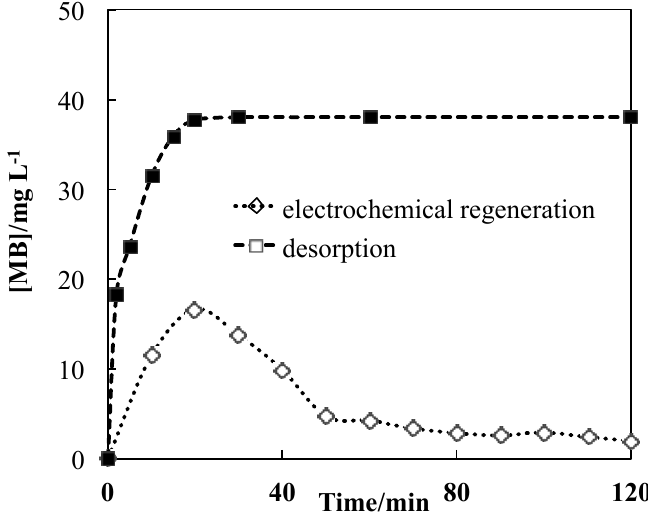
Fig. 4: Comparison of variation of MB concentration during desorption (full symbol) and electrochemical regeneration (empty symbol). [Na 2 SO 4 ] =0.1 M, m sawdust. = 1 g, q° = 21 mg/g. anode: BDD, i = 0.215 A/cm 2 , V = 100 mL, T = 303 K, anode DDB , cathode Platinum mesh.